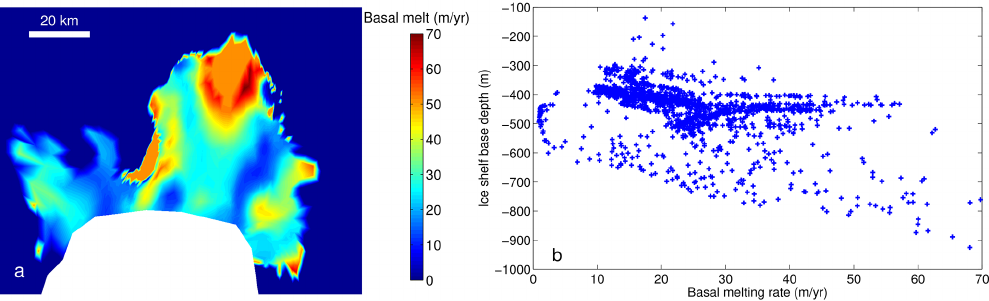
Figure 3. (a) Basal melting rate (in myr − 1 ) from the MITgcm filled with constant values (50myr − 1 ) over areas not covered by the MITgcm. (b) Basal melting rate values (in myr − 1 ) from the MITgcm represented as a function of ice shelf base depth.